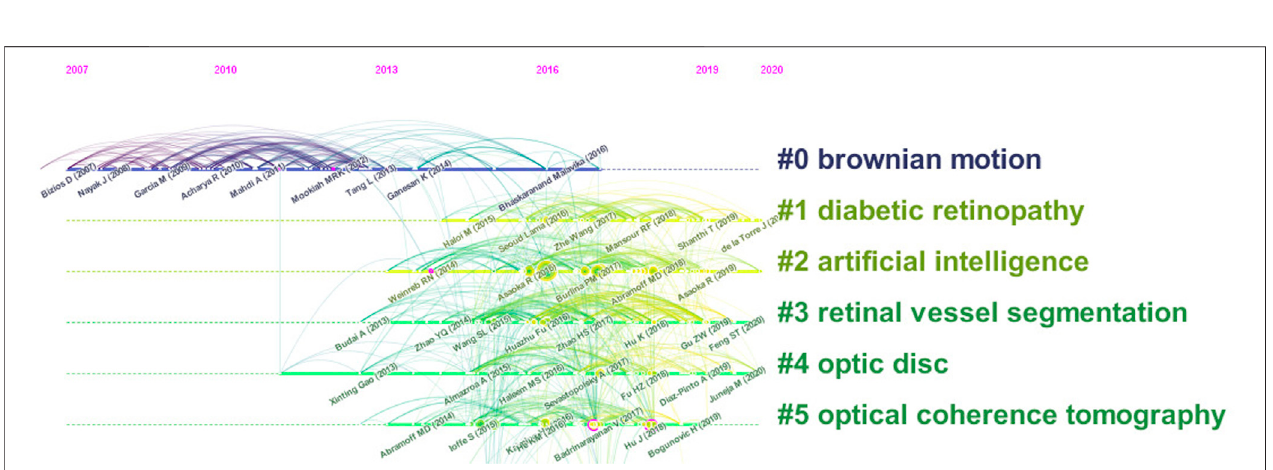
FIGURE 7 | Co-cited reference timeline map of publications on the use of AI in the diagnosis of ophthalmic diseases from 2012 to 2021.